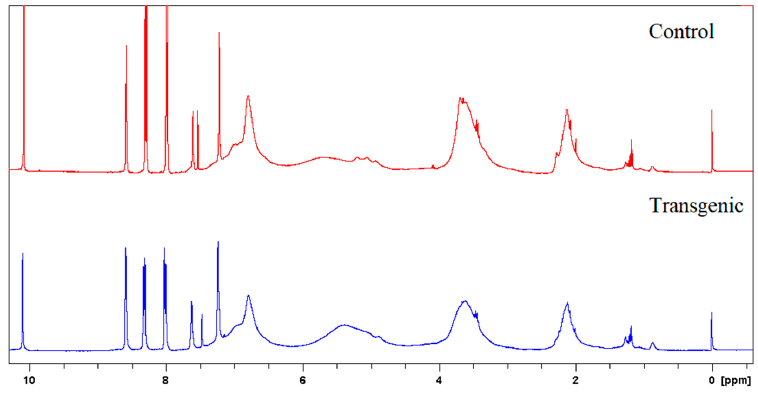
Figure 4. 1 H NMR spectra of acetylated LCs.